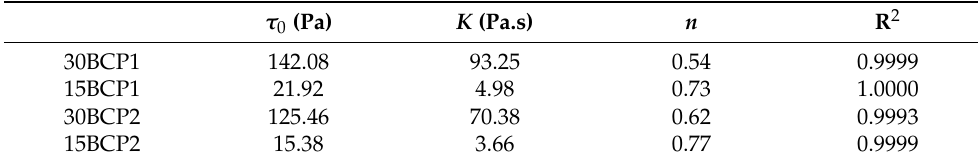
Table 1. The Herschel–Bulkley parameters for the different